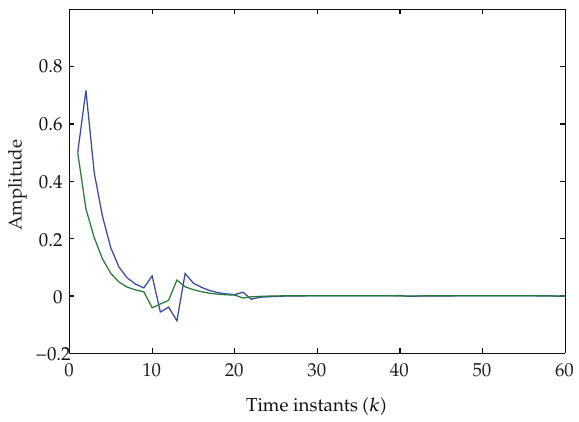
Figure 2: Trajectories of the system state in the simulation with the designed controller.